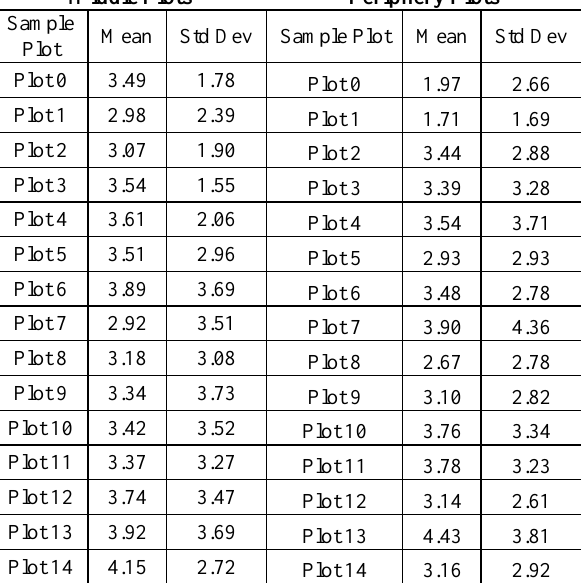
Figure 4. The derived Canopy Height Model (CHM) for the site in Brgy. Baloganon, Masinloc, Zambales, Philippines